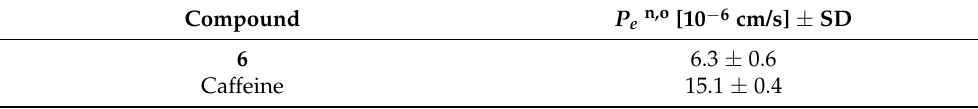
Table 3. Permeability coefficient of compound 6 .